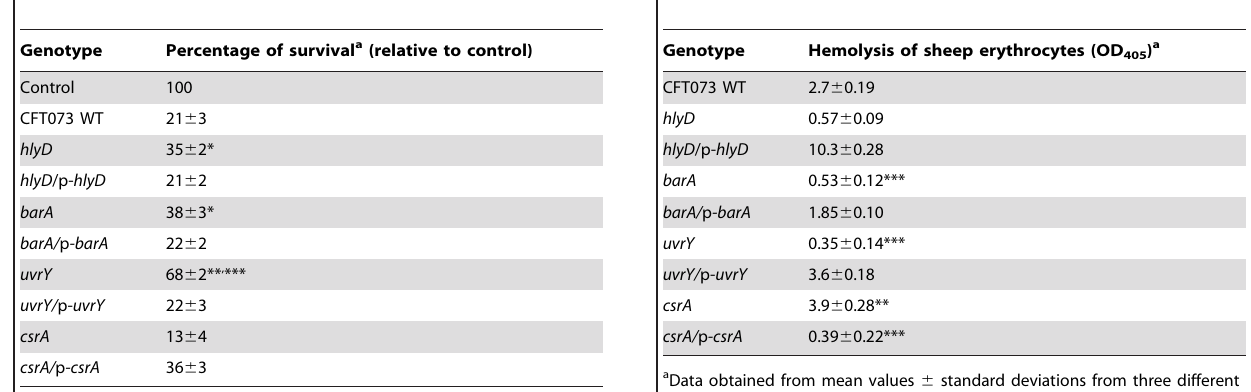
Table 5. Mutation in barA or uvrY decrease and csrA increase hemolysis of sheep